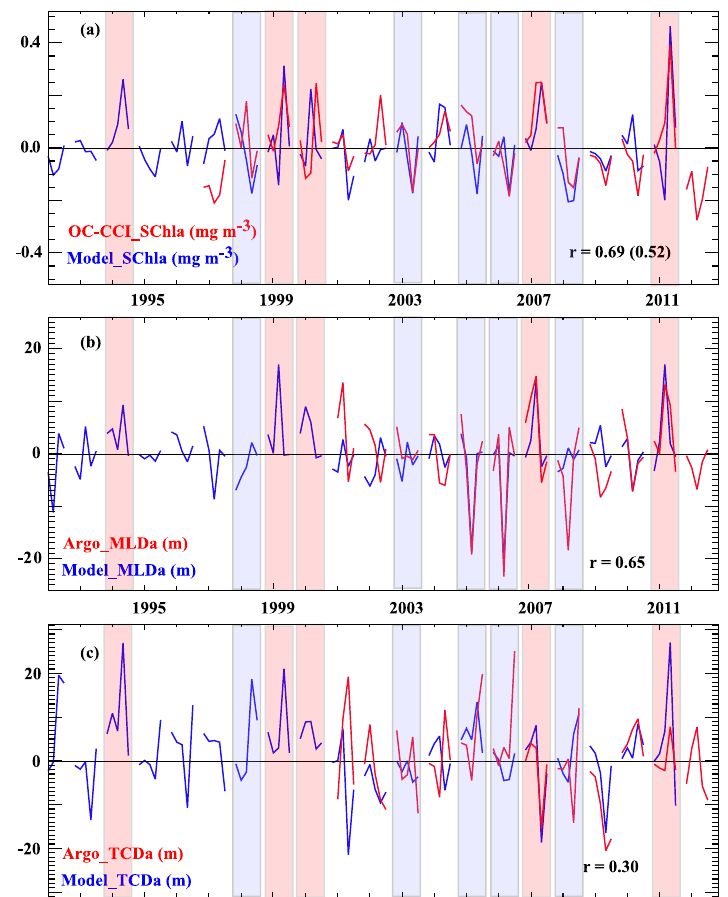
Figure 7. Monthly time series of NAS-box-averaged modelled and observed interannual anomalies in winter for (a) SChl, (b) MLD, and (c) TCD. The correlation between the model and observations from 2002 to 2012 is indicated in (a) – (c) . Red and blue shadings respectively indicate winters for strong and weak blooms in the model, considered for the composite plots of Fig. 10. Note that the model average is based on the entire NAS box, while observations subsample this box: the good agreement between the two averages however suggests that observational subsampling does not introduce large